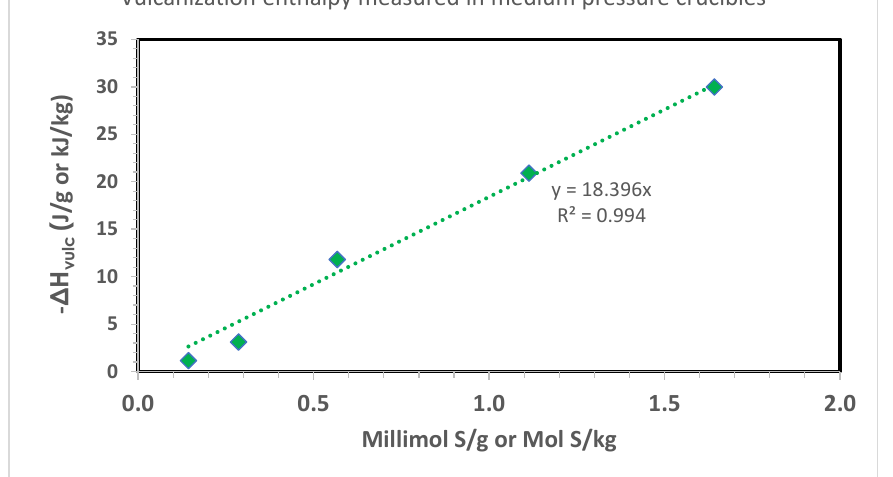
Figure 4. Vulcanization enthalpy measured with DSC on the compounds of Table 1. Heating rate 20 °C/min in stainless steel medium pressure crucibles from room temperature to 350 °C. The vulcan- ization thermal parameters are shown in Table 3.